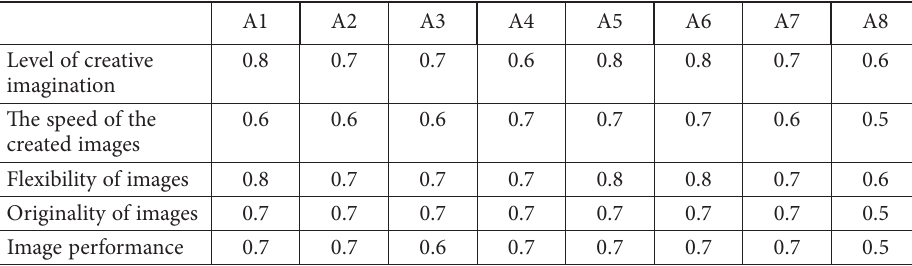
Table 3. Correlation analysis matrix for the connection of the creative imagination with its criteria and psychological conditions A1 A2 A3 A4 A5